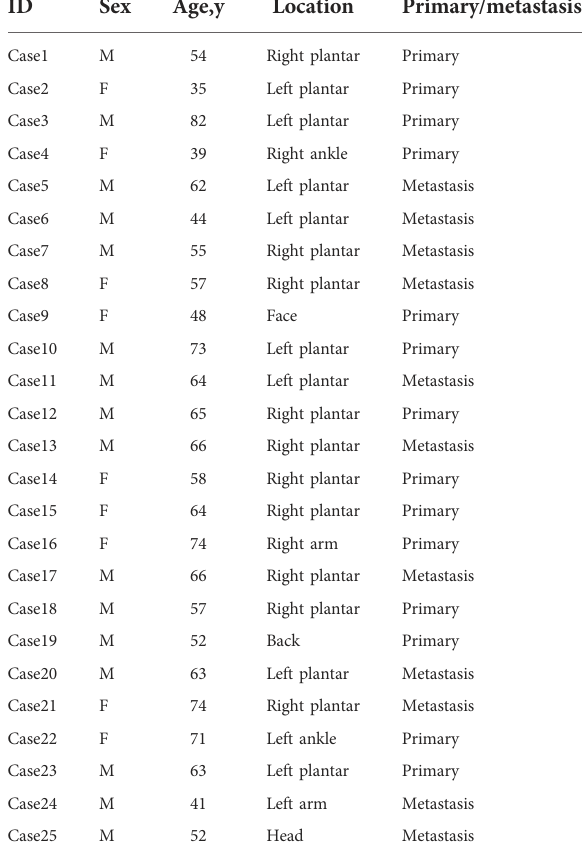
TABLE 5 Clinical characteristics of melanoma